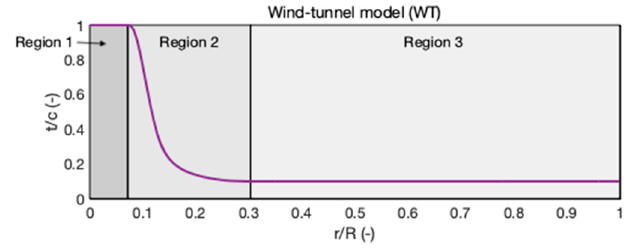
Figure 8. The radial distribution of the nondimensional thickness for the wind tunnel model.